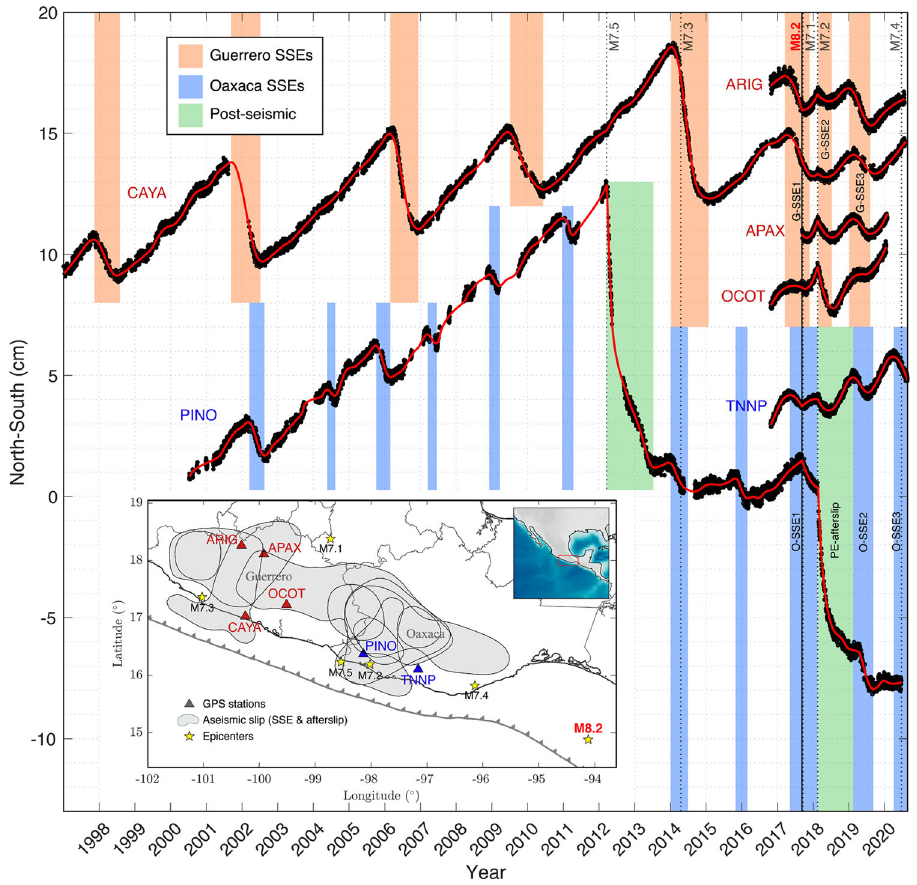
Fig. 8 Displacement time series in Guerrero (red triangles) and Oaxaca (blue triangles) GPS stations. The map shows the epicenters of major thrust earthquakes that occurred in the last 23 years in Mexico (M > 7, yellow stars near the coast) and the intraslab Mw7.1 Puebla – Morelos event. Gray shapes delineate the areas of aseismic slip larger than 1 cm determined in this study between November 2016 and October 2019 (see Fig. 3). All the aseismic events (SSEs and afterslip) observed in the time series since 1997 are indicated with vertical-colored bands. Note the change in the temporal deformation patterns throughout the entire region after the great Mw8.2 Tehuantepec earthquake. The O-SSE3, not studied here, initiated two months before the Mw7.4 Huatulco earthquake of June 23, 2020 32